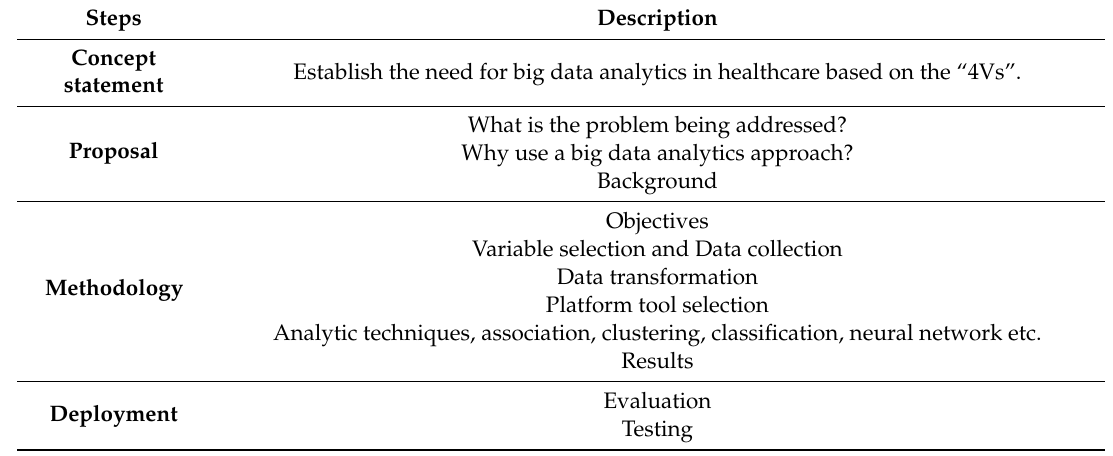
Table 1. Outline of big data analytics in healthcare recommender